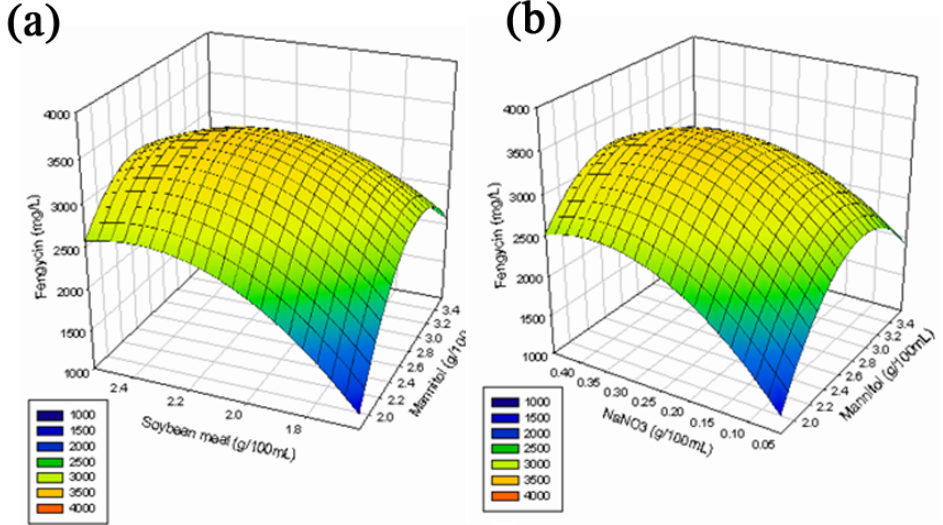
Figure 1. ( a ) Response surface curve based on mannitol and a soybean meal; ( b ) Response surface curve based on mannitol and NaNO ; ( c ) Response surface curve based on 3 ·4H O; ( d ) Response surface curve based on a soybean meal and mannitol and MnSO 4 2 NaNO ; ( e ) Response surface curve based on a soybean meal and MnSO 3 ( f ) Response surface curve based on NaNO and MnSO ·4H 3 4 2